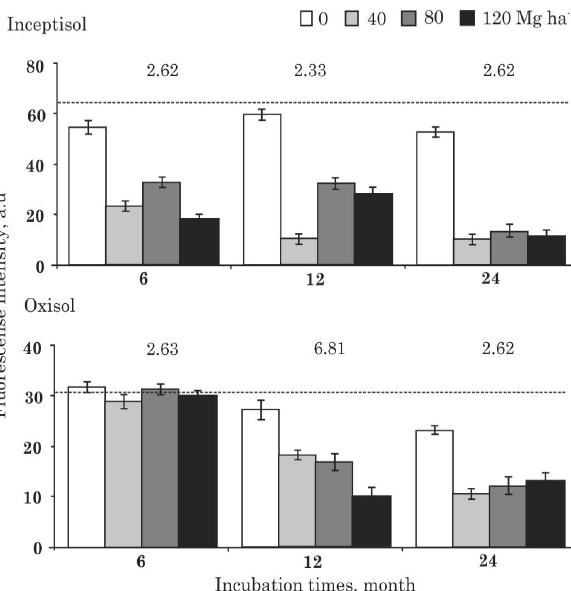
Figure 5. Fluorescence intensity of humic acids isolated from Inceptisol and Oxisol samples for different doses of filter cake application. Error bars represent the standard error of the mean. Horizontal dashed lines represent values for untreated soil at the beginning of the experiment. Numbers refer to least significant difference (Tukey test, p <